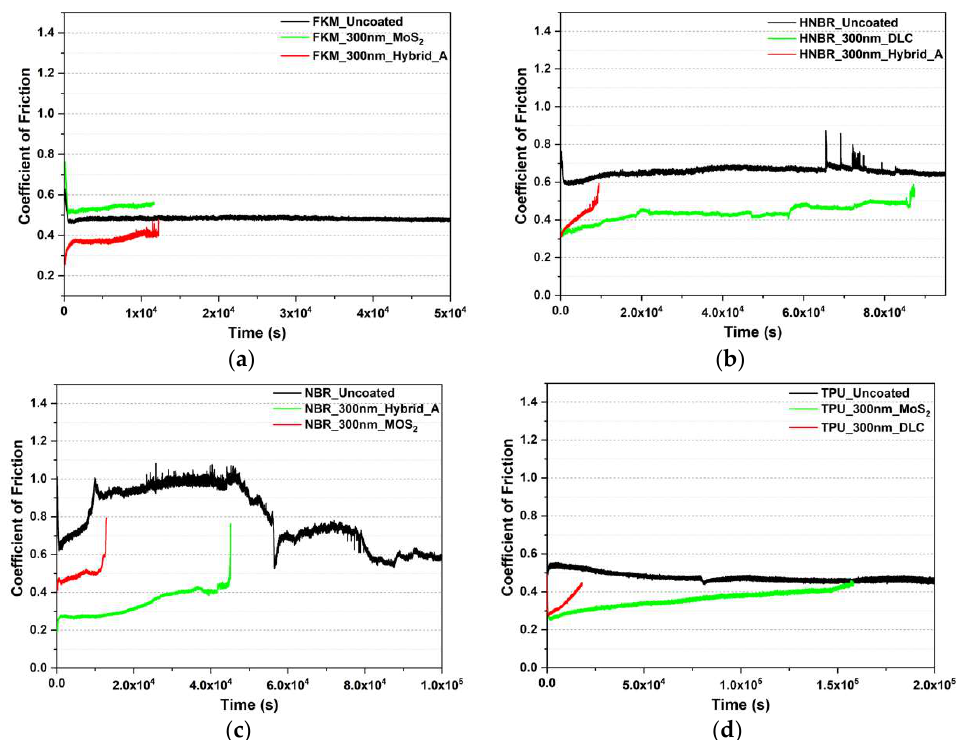
Figure 8. Comparison of the COF: uncoated and coated in Ring on disc test. ( a ) FKM; ( b ) HNBR; ( c ) NBR; ( d ) TPU.